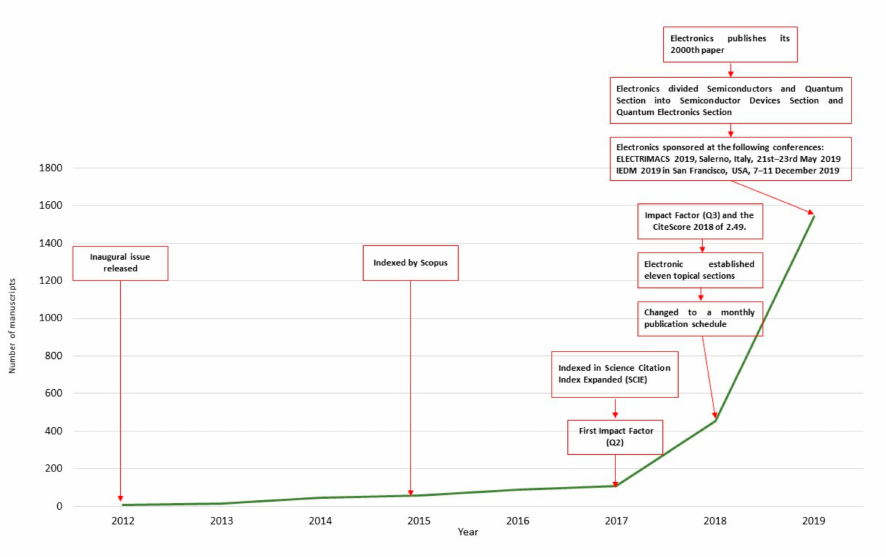
Figure 3. Journal